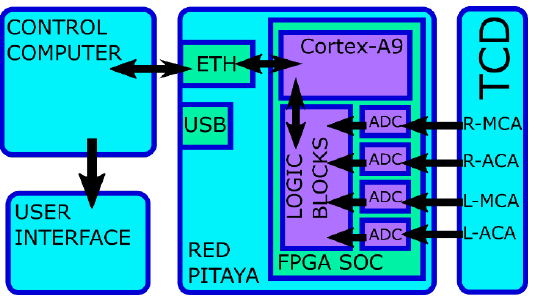
Figure 1. Block diagram with the different parts of the Transcranial Doppler Ultrasound (TCD)-based neurofeedback system.